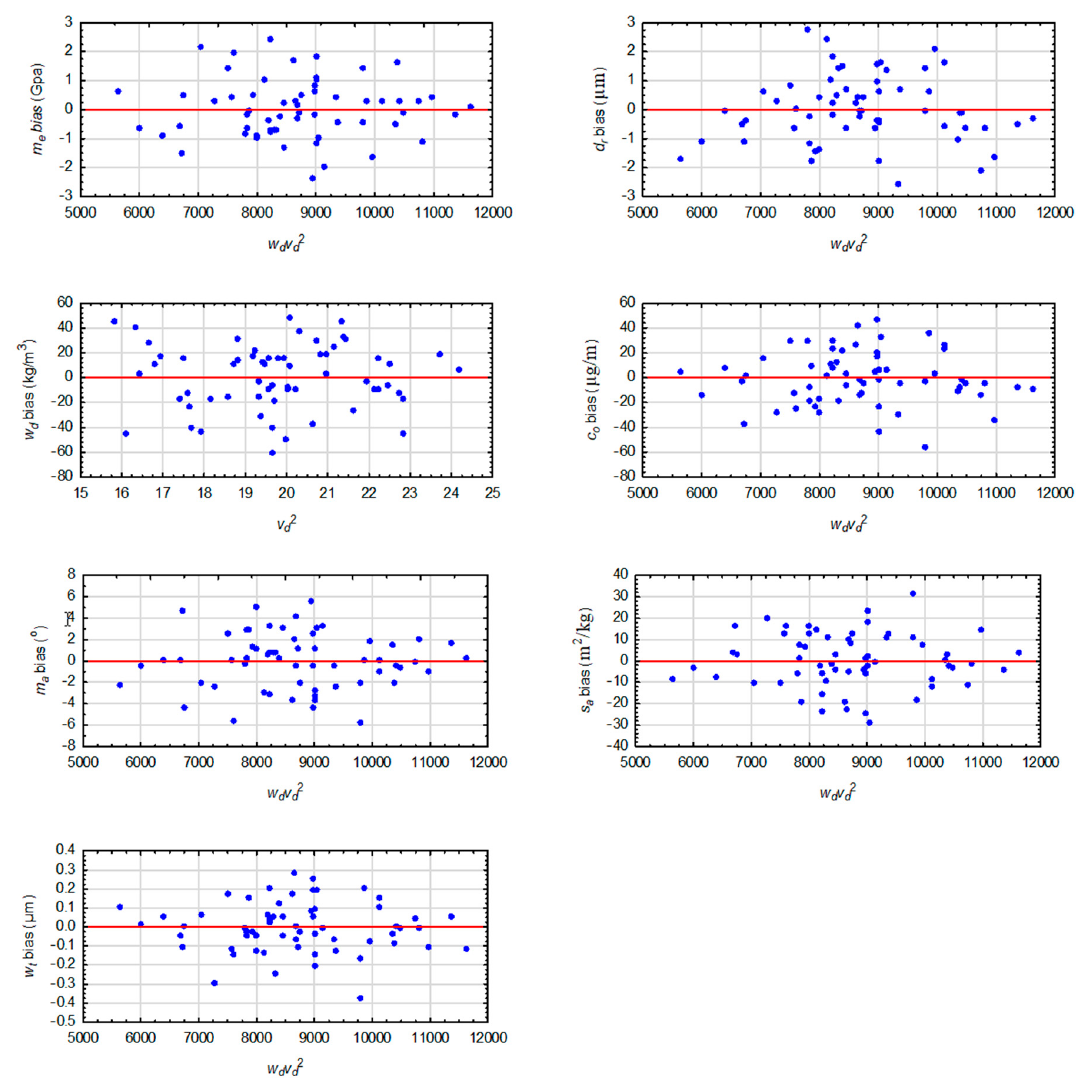
Figure3. Attribute-specificabsolute bias (residual) plotsfor significant ( p ≤ 0.05) regressionrelationships (Table 4, Figure